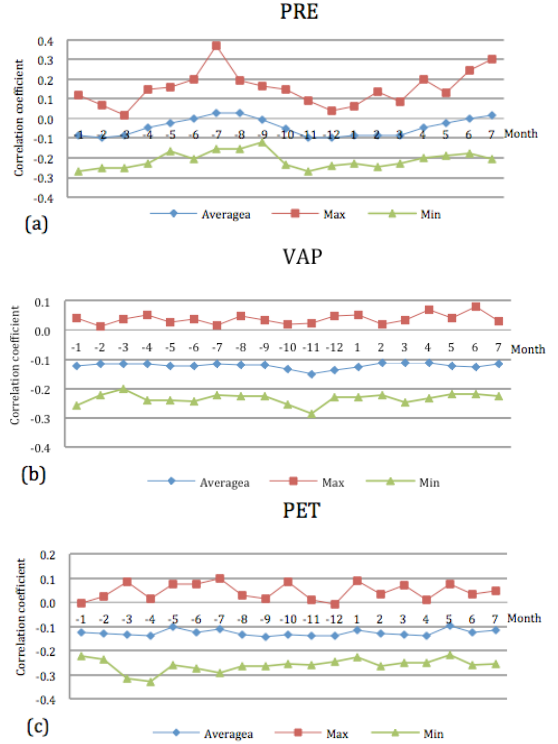
Figure 6. The max (red), mean (blue), and min (green) correlation coefficients for Cerulean warbler, in terms of (a) PRE, (b) VAP, and (c) PET. The tick labels of x axis from -1 to 7 mean the months from last January to this July for each year. Specifically, for Carolina wren, the best correlation with PRE occurred in the January of the same year, with the determination coefficient of 0.33; the highest correlation with VAP emerged in the August of the last year, with the correlation coefficient of 0.45; the best correlation with PET happed in the February of the same year, with the coefficient of 0.42. It can be noticed that for VAP, the monthly correlation coefficients are relatively smooth. This is because vapor pressure rises and drops steadily within the study